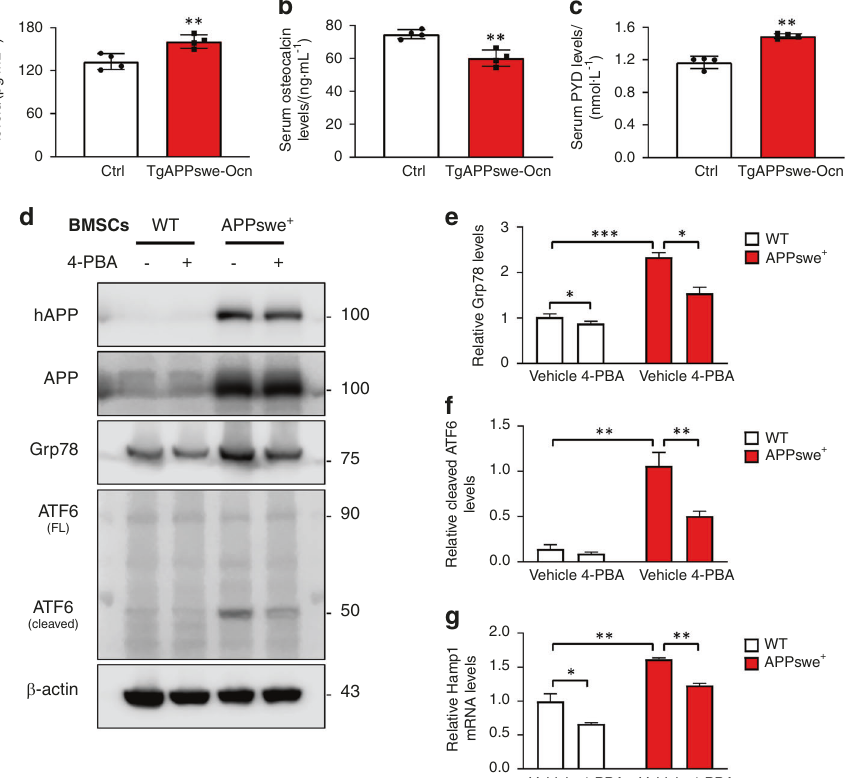
Fig. 6 ER stress induces the expression of hepcidin in APPswe + BMSCs. a Analysis of serum hepcidin levels in 3-month-old ctrl and TgAPPswe- Ocn mice by ELISA. ** P <0.01 (signi fi cant difference). b Analysis of serum osteocalcin (Ocn) levels in 3-month-old ctrl and TgAPPswe-Ocn mice by ELISA. The mean±SD of measurements from four males per genotype are shown. ** P <0.01 (signi fi cant difference). c Elisa analysis of serum pyridinoline (PYD) levels. The values of mean ±SD ( n = 4) were presented. ** P <0.01 (signi fi cant difference). d Western blot analysis of the expression of the indicated proteins in BMSCs from mice of the indicated genotypes (at the age of 3 months). Cells were treated with vehicle or 1mmol·L − 1 4-PBA for 24h. β -Actin was used as a loading control. e , f Quantitative analysis (mean ±SD; n = 3). * P <0.05; ** P <0.01; *** P <0.001. g Real-time PCR analysis of hepcidin expression in WT and APPswe + BMSCs cultured with or without 4-PBA (1mmol·L − 1 ). * P <0.05; ** P <0.01 (signi fi cant